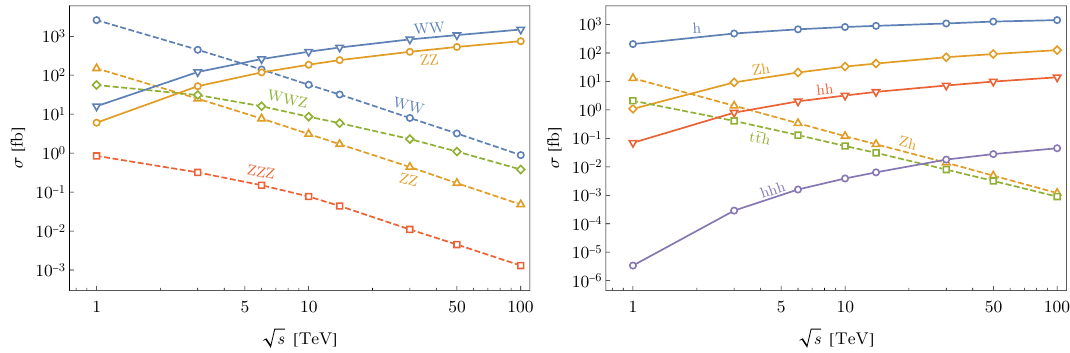
Figure 2: Cross sections for some representative annihilation (dashed) and VBF (solid) standard model processes as a function of the µ + µ − collision energy produced from Ref. [ 3 ] licenced under CC-BY